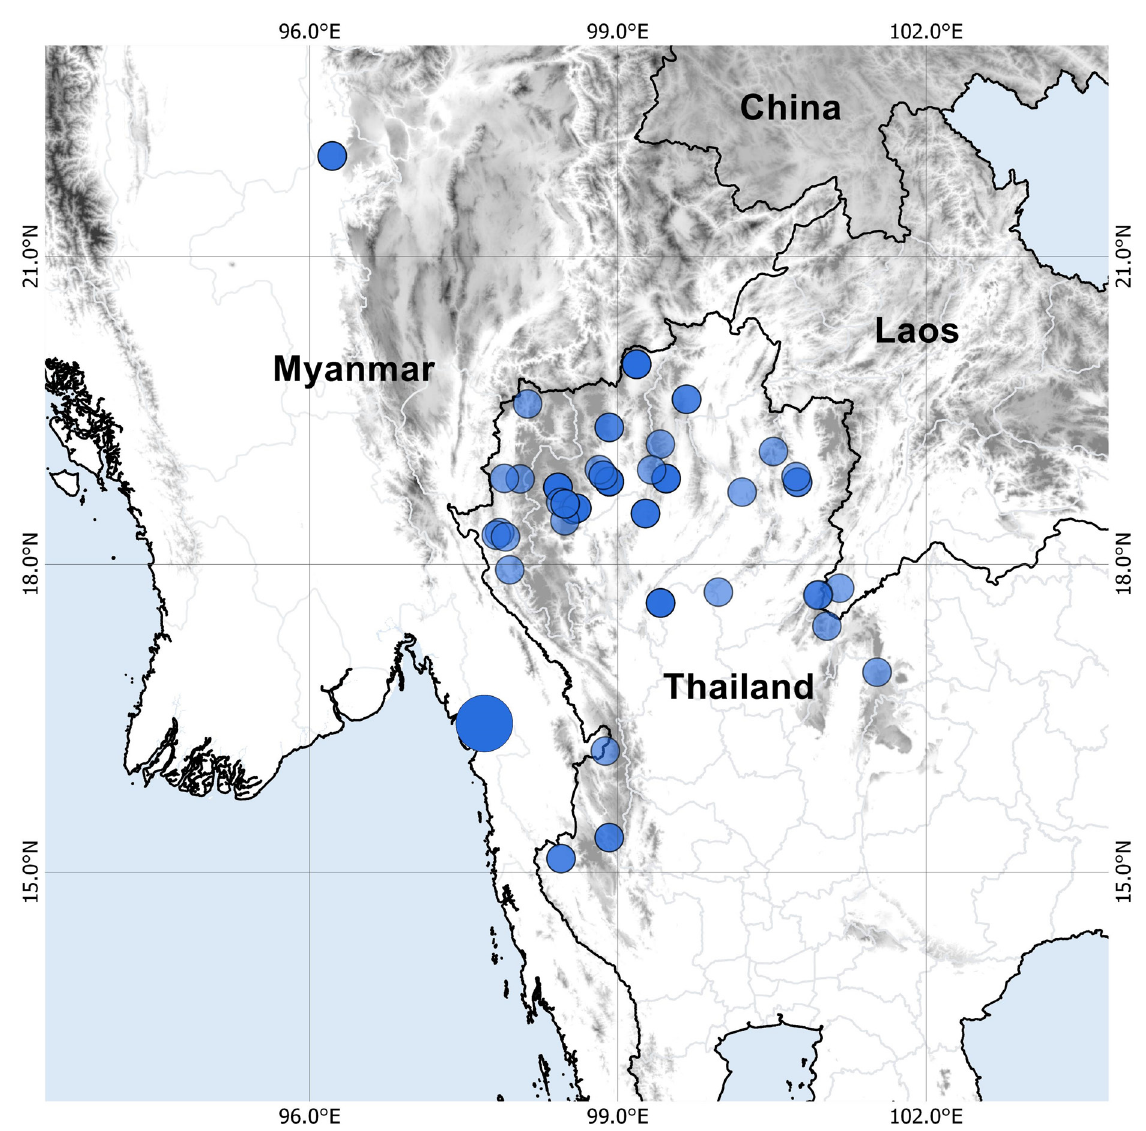
Fig. 8. Distribution range of G. expansa Wall. ex Horan. The type locality is indicated by a bigger